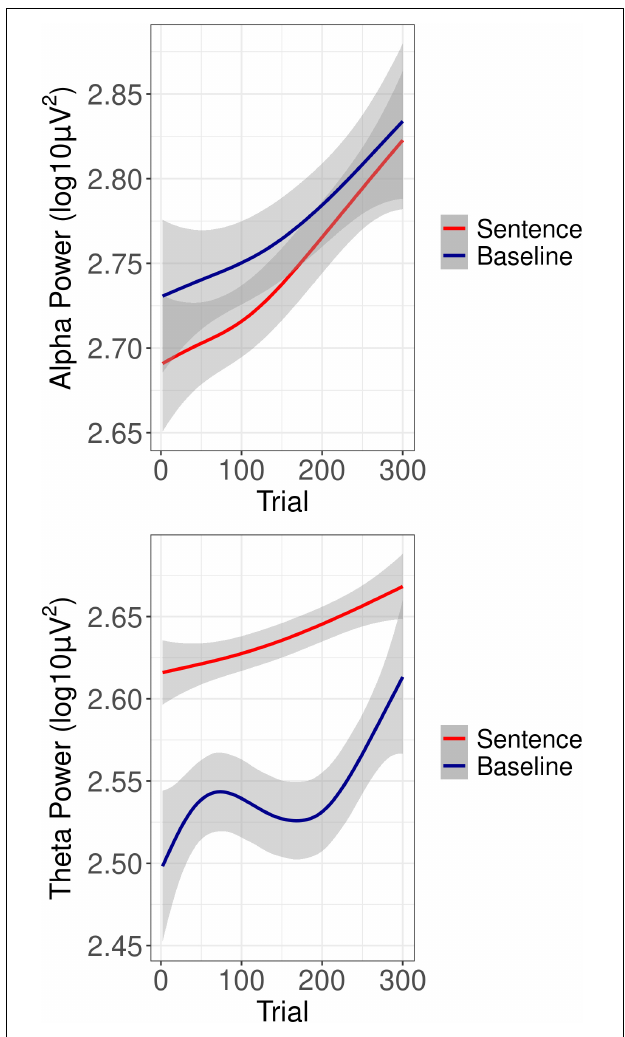
FIGURE 4 | Overall oscillatory power as a function of trial. Shown is the overall oscillatory power as a function of trial in the alpha-band (Top) and theta-band (Bottom) for both sentence processing (red lines) and baseline (blue lines)